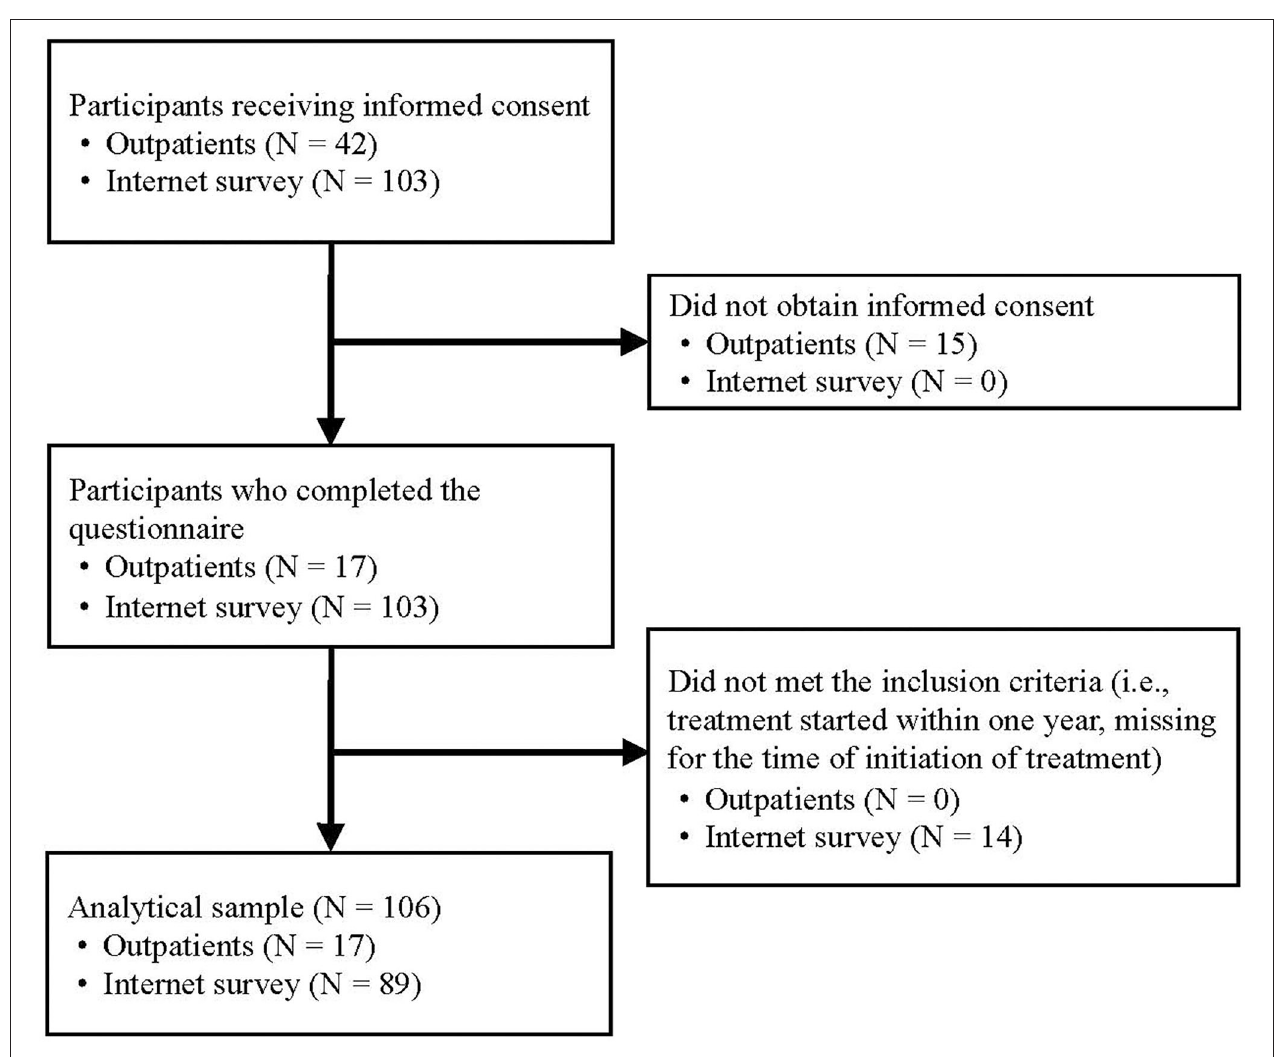
FIGURE 1 | Requirement flow